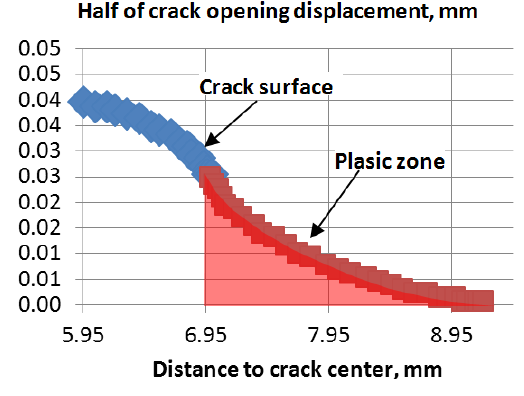
Figure 6: Crack profile. Figure 7: Convergence of CTOD calculation.